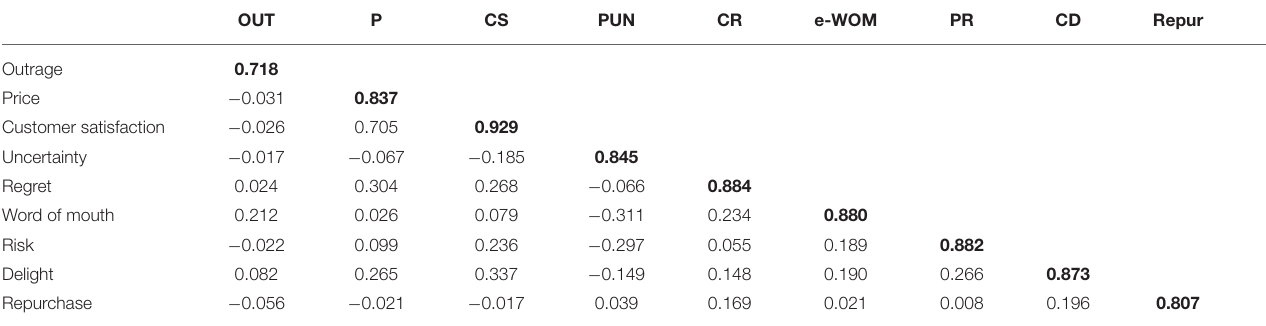
TABLE 3 | Discriminant